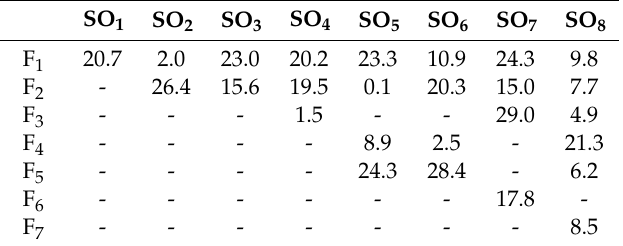
Table 6. Diagnosis expense (RMB).